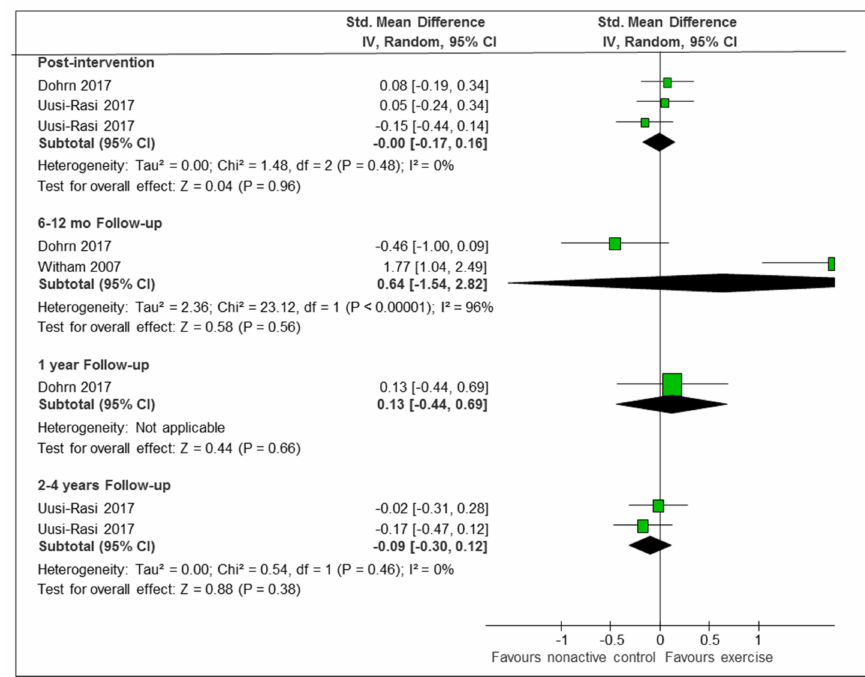
Figure 4. Exercise-based intervention versus non-active control (objective measures of PA). Abbreviations: Std. Mean Di ff erence: standardized mean di ff erence; IV, Random: a random-e ff